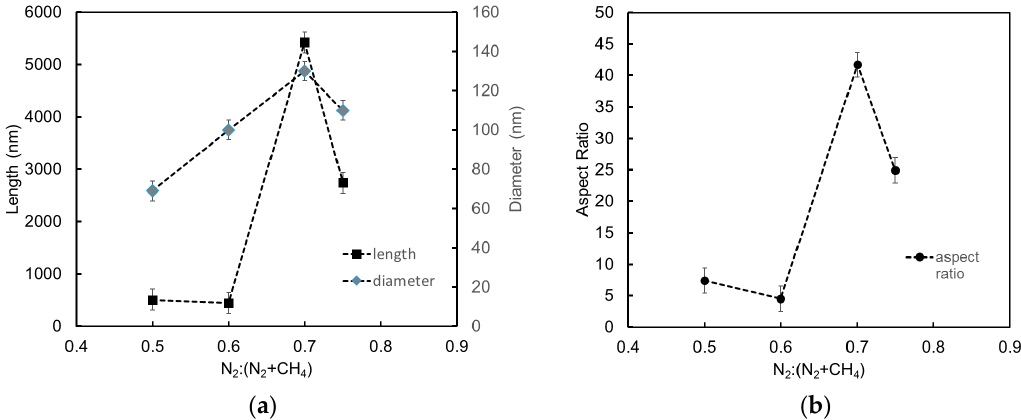
Figure 2. Variation of fiber length and diameter ( a ), and aspect ratio ( b ) with N 2 :(N 2 + CH 4 ).